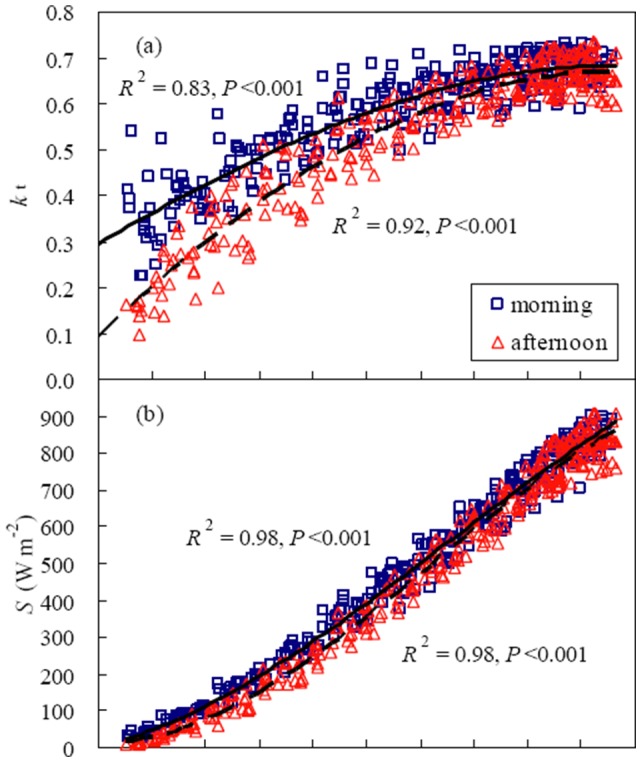
Scatter plots and regressions between (a) the clearness index (k
t) and the sine of solar elevation angles (sinβ), and (b) global solar radiation (S) and sinβ for a winter wheat field in April-May 2003.The data were fitted by cubic polynomials in the morning (solid line) and afternoon (dashed line), respectively.